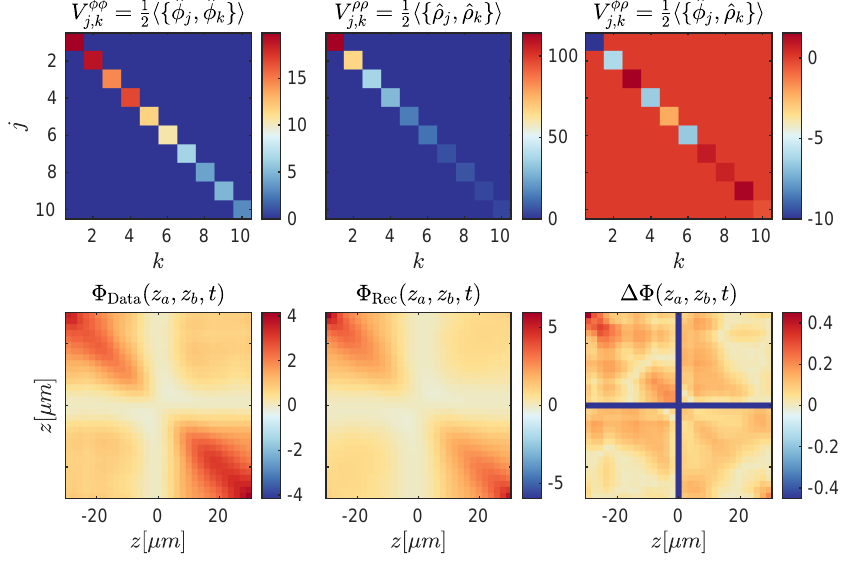
Figure 20: A reconstruction for the same experimental scan as in Fig. 8 but with a re- striction of the eigen-mode correlations to the diagonal, i.e., instead of a reconstruc- tion over unrestricted Gaussian states, here, we restrict the variational states with an additional product-state constraint in eigen-mode space. We notice a remarkable stability of the values of correlations on the diagonal. The absence of off-diagonal eigen-mode correlations due to the restriction leads to a reduced fidelity of the fit. While the precision is a little worse, the accuracy of extrapolation of the time evo- lution is improved as the restriction forces proximity to steady states which behave more stably upon extrapolation outside of the input time